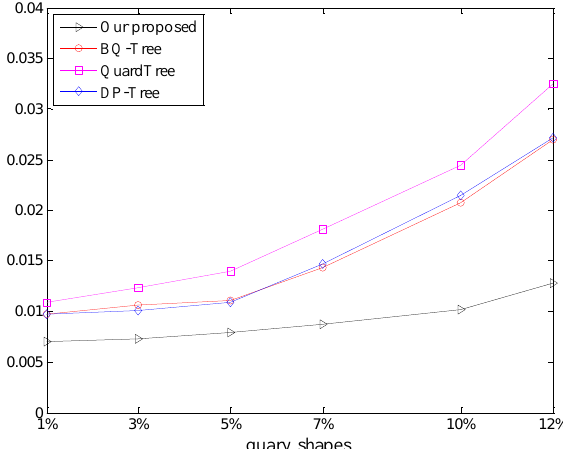
Figure 9. Privacy budget ε = 0.5.